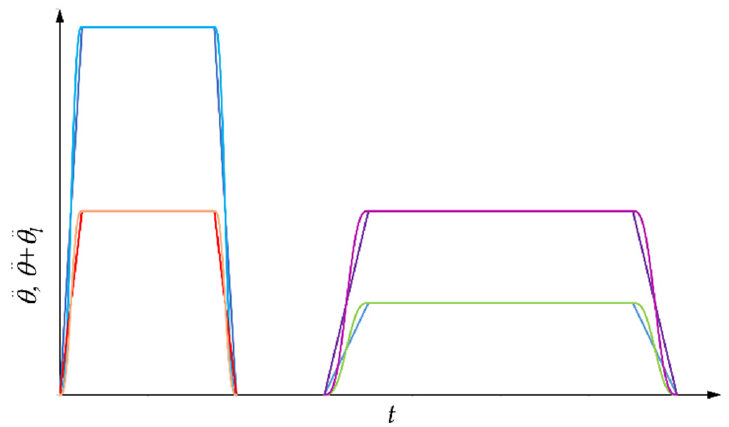
Figure 10. Different motor and load acceleration profiles with the same SC. This means that the SCs depend only on the product f n t a (and k j ). This property reduces the number of possible SCs to be studied. If the system is damped, the SCs also depend on ζ .